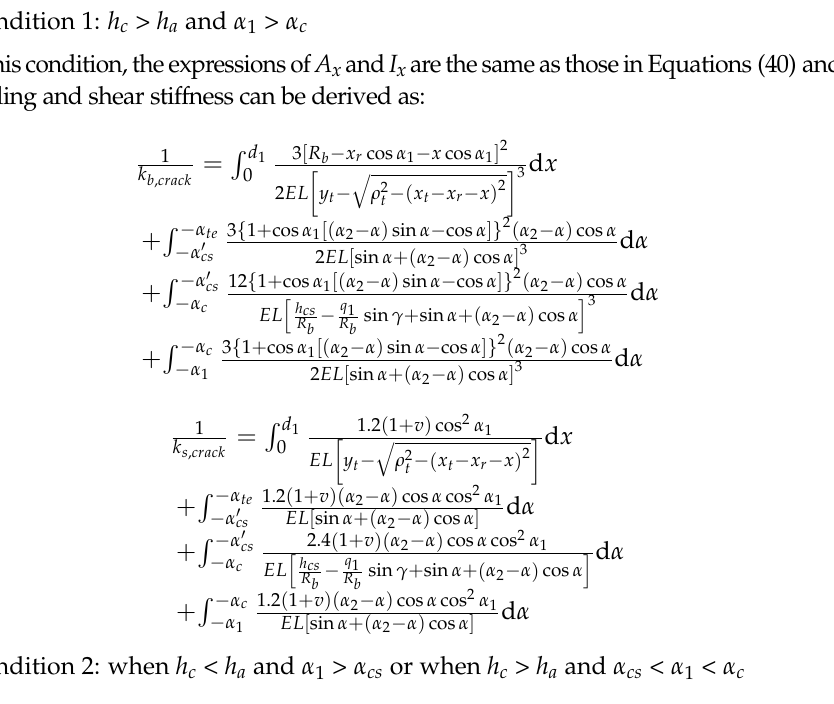
Figure 8. Tooth model with a crack on the tooth surface for d cs − q 1 cos γ > d